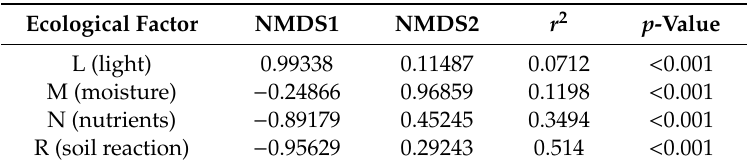
Table A6. Vectors of environmental factors in the ordination space and their correlation with variation